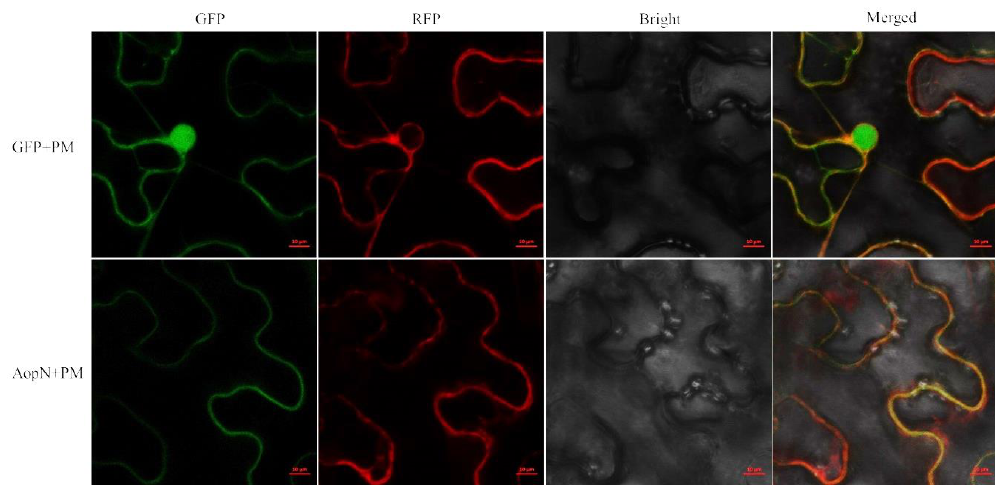
Figure 4. Subcellular localization of AopN. The leaves injected with Agrobacterium tumefaciens GV3101 strain carrying 35S: AopN-fused green fluorescent protein (GFP) were sampled and observed under a confocal microscope (20 ×). A plasma membrane (PM) marker carrying red fluorescent protein (RFP)